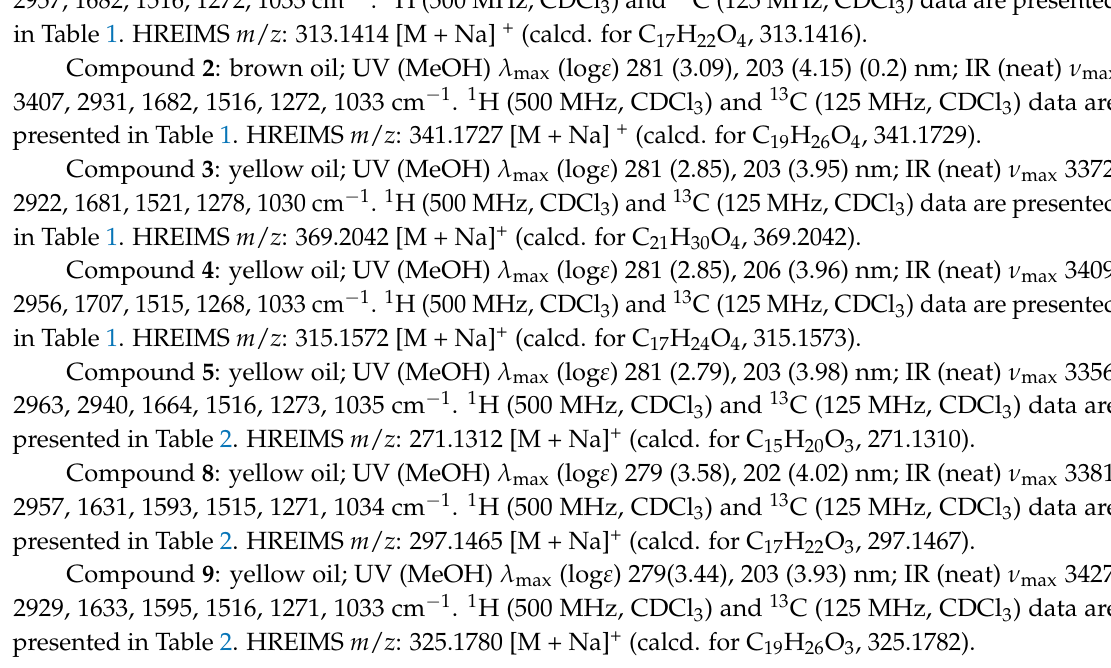
in Table 1. HREIMS m / z : 313.1414 [M + Na] + (calcd. for C 17 H 22 O 4 , 313.1416). Compound 2 : brown oil; UV (MeOH) λ max (log ε ) 281 (3.09), 203 (4.15) (0.2) nm; IR (neat) ν max presented in Table 1. HREIMS m / z : 341.1727 [M + Na] + (calcd. for C 19 H 26 O 4 , 341.1729). Compound 3 : yellow oil; UV (MeOH) λ max (log ε ) 281 (2.85), 203 (3.95) nm; IR (neat) ν max 3372, in Table 1. HREIMS m / z : 369.2042 [M + Na] + (calcd. for C 21 H 30 O 4 , 369.2042). Compound 4 : yellow oil; UV (MeOH) λ max (log ε ) 281 (2.85), 206 (3.96) nm; IR (neat) ν max 3409, 2956, 1707, 1515, 1268, 1033 cm − 1 . 1 H (500 MHz, CDCl 3 ) and 13 C (125 MHz, CDCl 3 ) data are presented in Table 1. HREIMS m / z : 315.1572 [M + Na] + (calcd. for C 17 H 24 O 4 , 315.1573). Compound 5 : yellow oil; UV (MeOH) λ max (log ε ) 281 (2.79), 203 (3.98) nm; IR (neat) ν max 3356, 2963, 2940, 1664, 1516, 1273, 1035 cm − 1 . 1 H (500 MHz, CDCl 3 ) and 13 C (125 MHz, CDCl 3 ) data are presented in Table 2. HREIMS m / z : 271.1312 [M + Na] + (calcd. for C 15 H 20 O 3 , 271.1310). Compound 8 : yellow oil; UV (MeOH) λ max (log ε ) 279 (3.58), 202 (4.02) nm; IR (neat) ν max